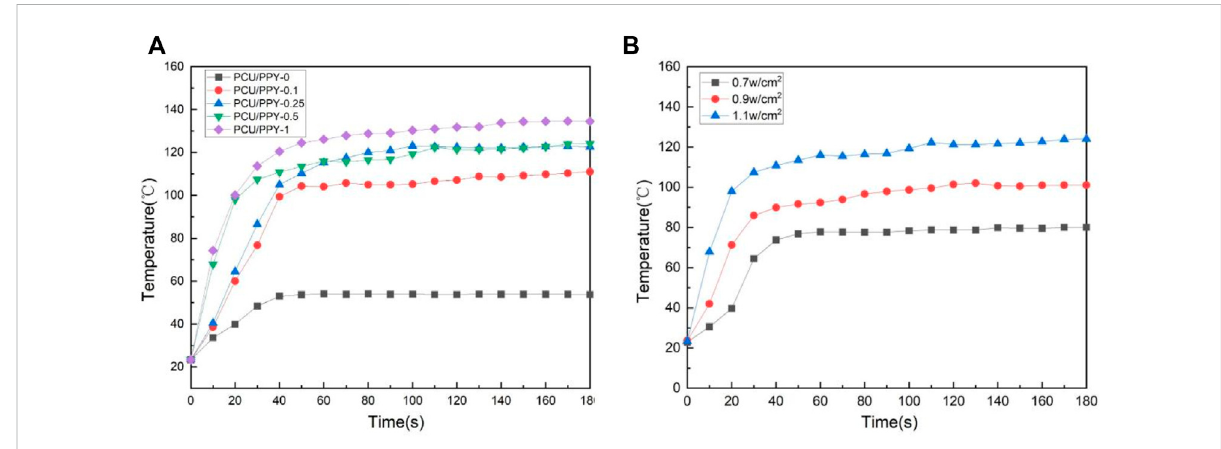
FIGURE 8 (A) Photothermal properties of PCU/PPy-x under NIR light (1.1w/cm 2 ). (B) Photothermal properties of different output